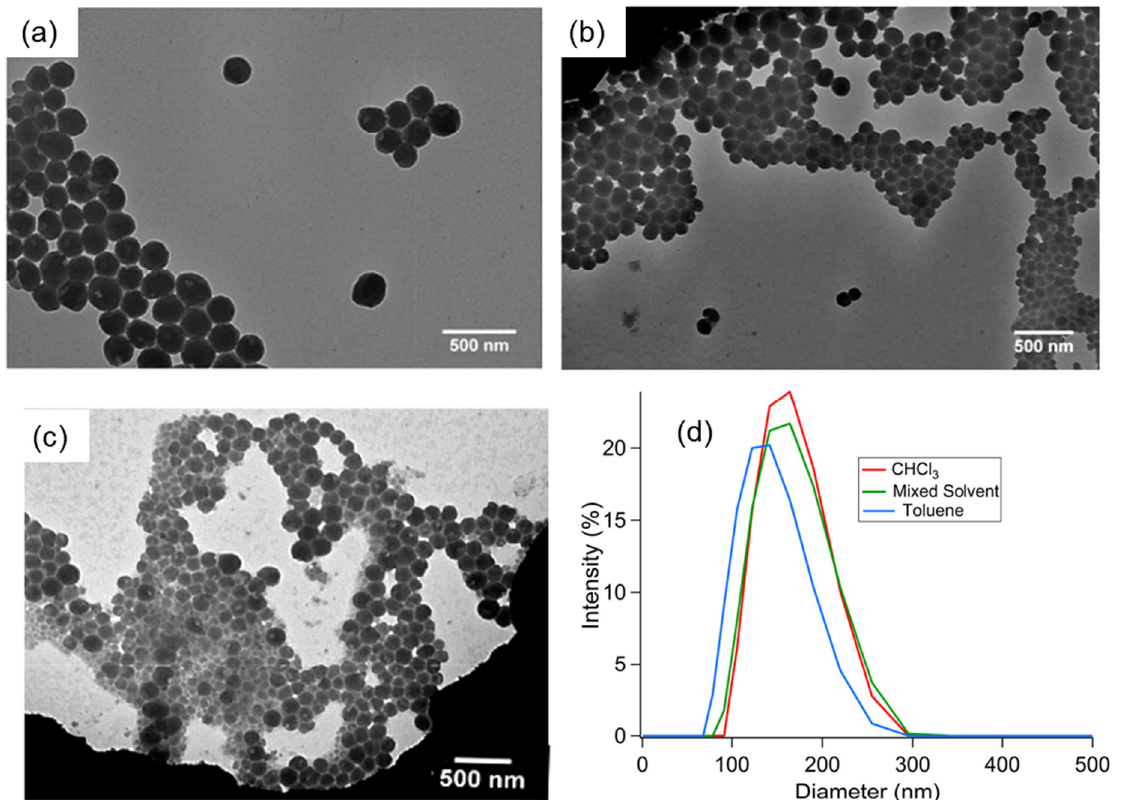
Figure 17. Representative TEM images of the P3HT nanoparticles synthesized from ( a ) chloroform, ( b ) toluene/chloroform (1:4 v / v ), ( c ) toluene, and ( d ) intensity particle size distribution of P3HT nanoparticles obtained from DLS. Reprinted with permission from ref. [107]. 2012 American Chemical